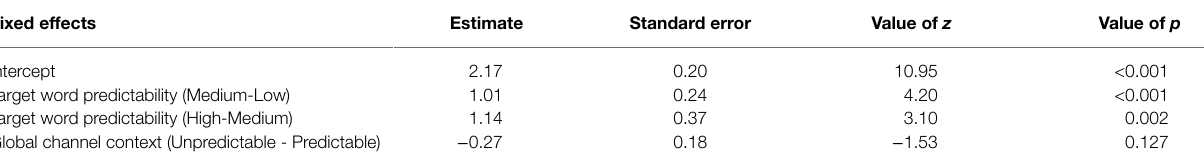
TABLE 6 | Estimated effects of the generalized (binomial logistic) mixed-effects model accounting for the correct word recognition at 4 channels